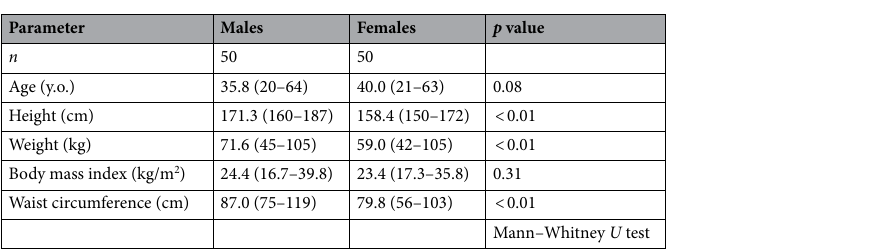
Table 1. Participants’